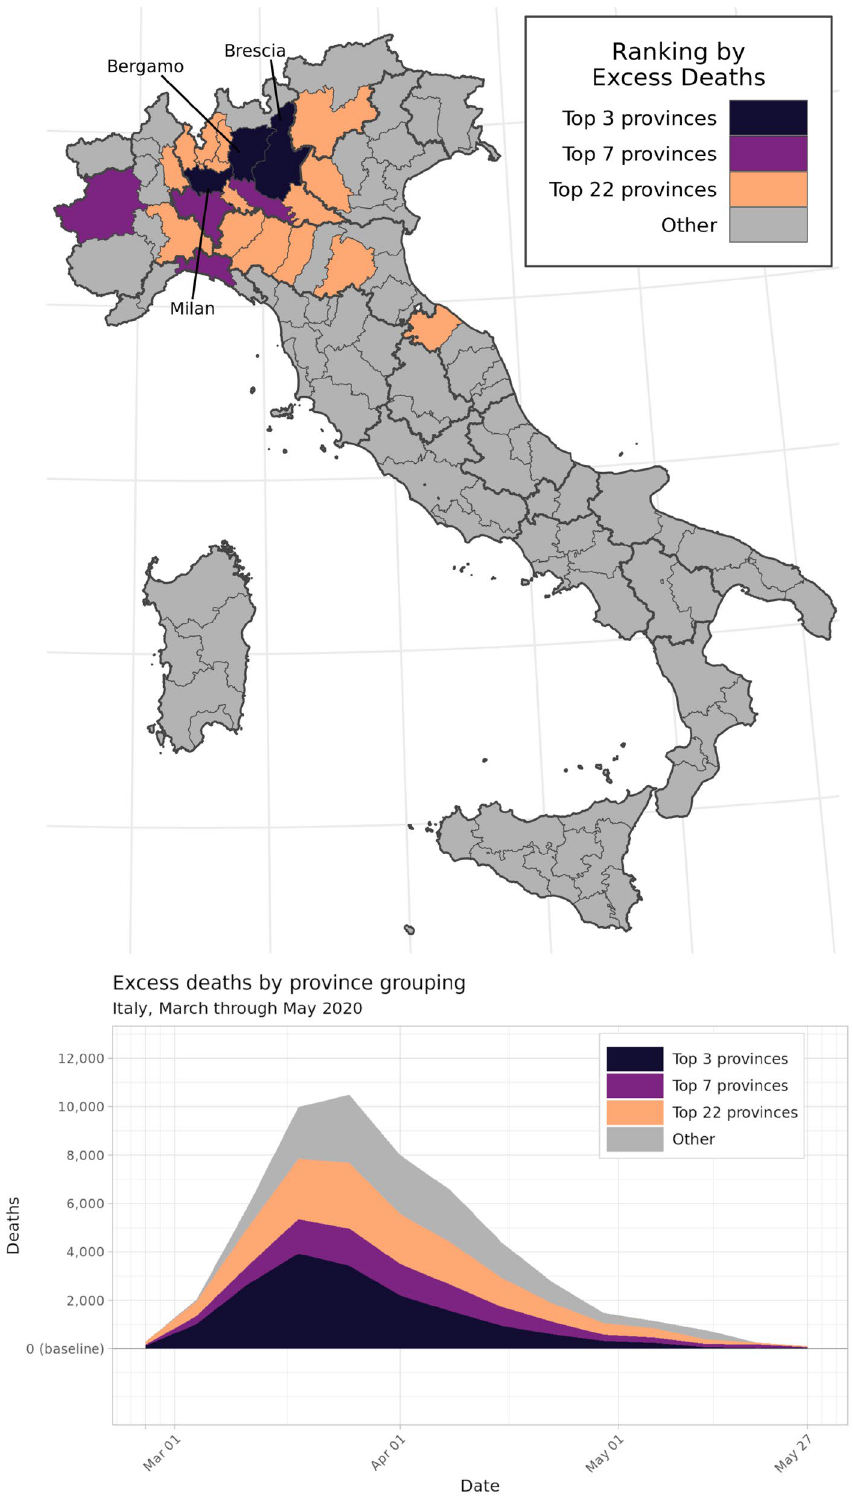
Figure 5. Concentration of excess mortality burden among the 3, 7, and 22 provinces with the greatest number of excess deaths, out of 107 provinces total. These province groupings respectively accounted for over 25%, 50%, and 75% of the national excess mortality burden between March and May 2020. The graph on the bottom left displays mean estimated excess deaths by province grouping and week during this